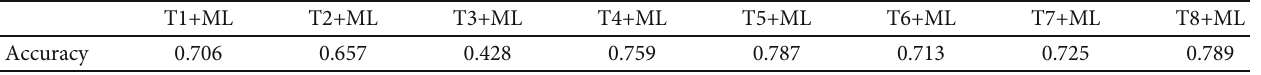
Table 5: Average classi fi cation accuracy of “ trace feature+manifold learning ” in 5 times 10-fold cross validation.